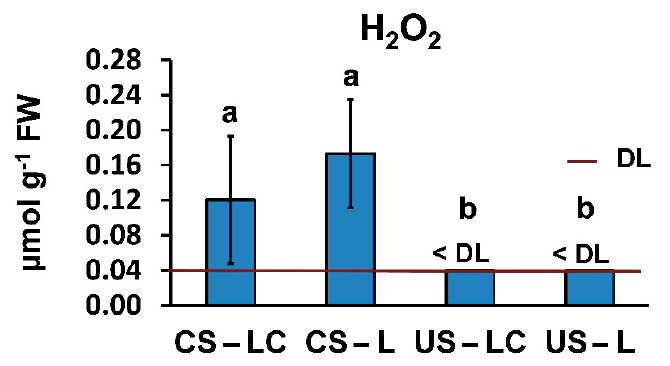
Figure 5. Hydrogen peroxide (H 2 O 2 ) contents in shoots of L. pedunculata grown from S ã o Domingos seeds (LC) and Caldeir ã o seeds (L) planted in the contaminated soil from S ã o Domingos (CS) and the uncontaminated soil from Caldeir ã o (US) (average ± standard error; n = 4). Different letters indicate significant differences among soil/plant treatments ( p < 0.05). DL: detection limit.